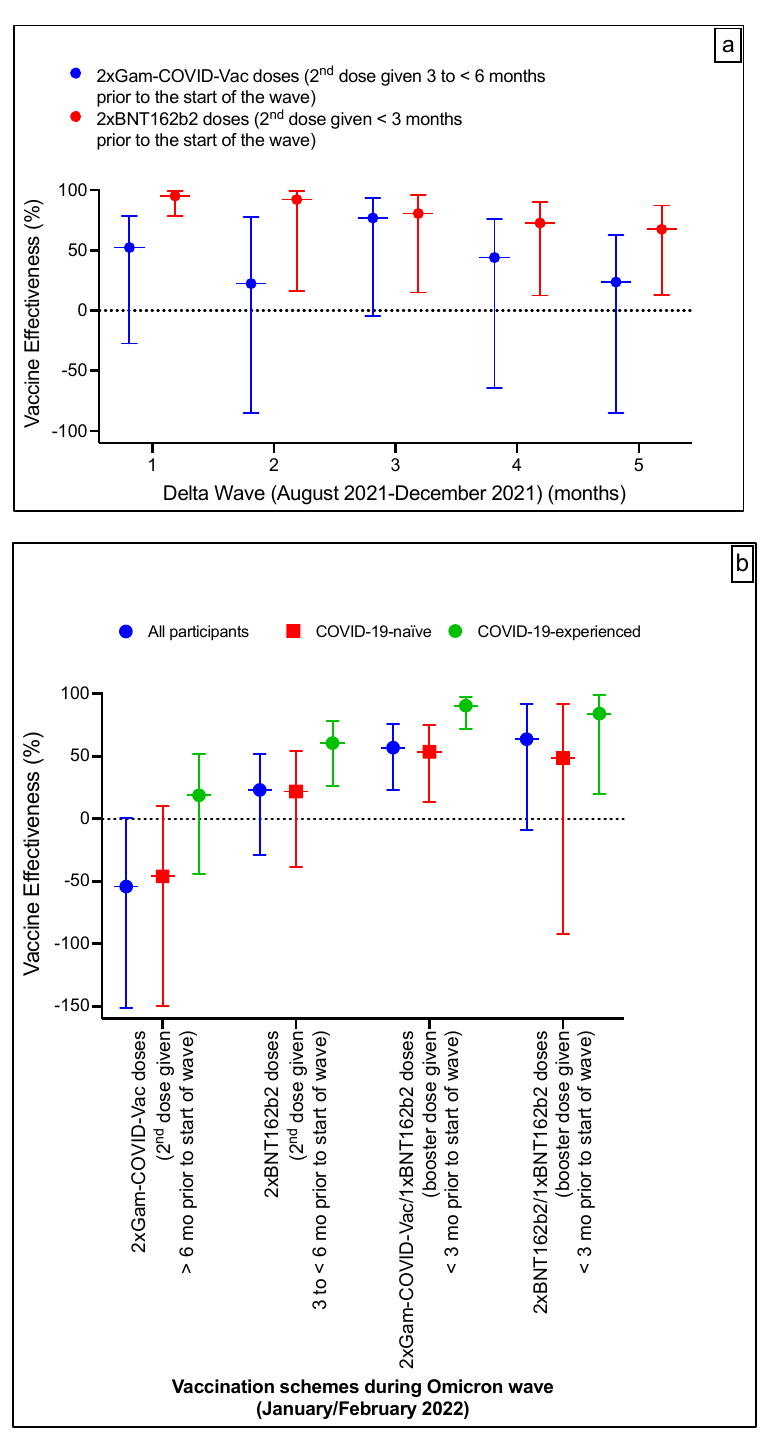
Figure 2. Effectiveness of the available COVID-19 vaccination schemes during the Delta wave ( a ) and Omicron Wave ( b ). N.B. Data are presented as effectiveness point estimates, with error bars indicating the corresponding 95% confidence